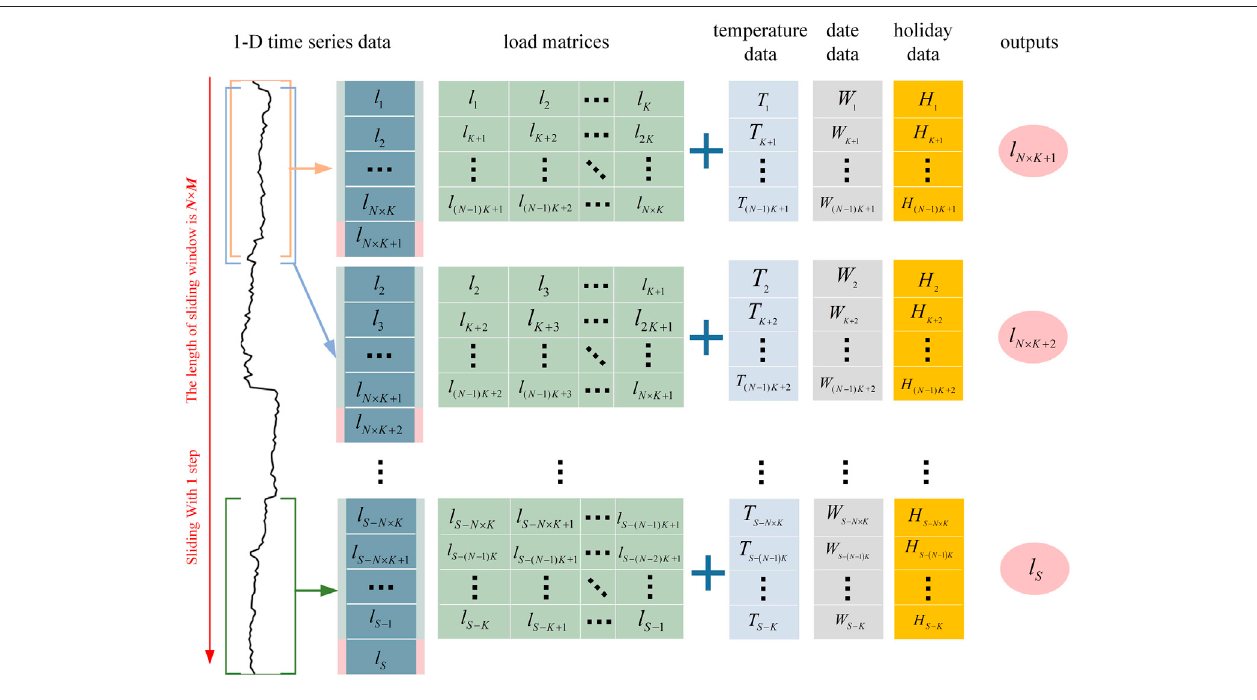
FIGURE 4 | Diagram of 1D time series to 2D matrix transforming.